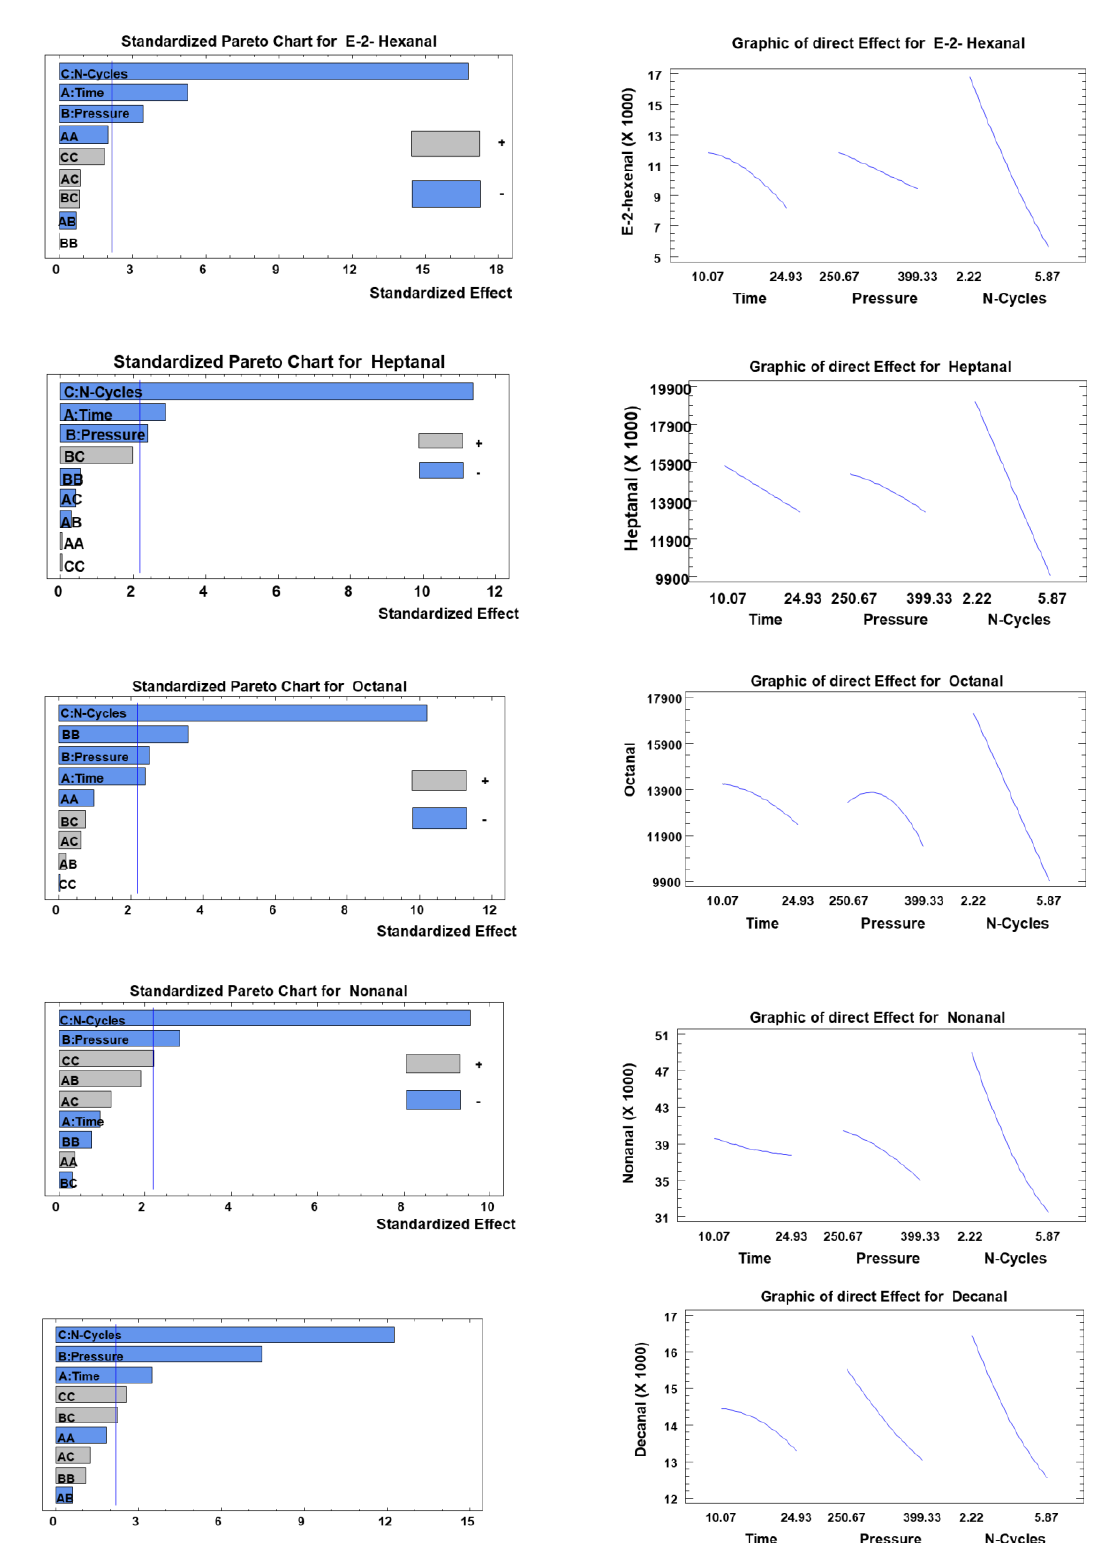
Figure 5. Standardized Pareto plots of MFA operating parameters t, P, and C on the deodorization of each volatile compound.